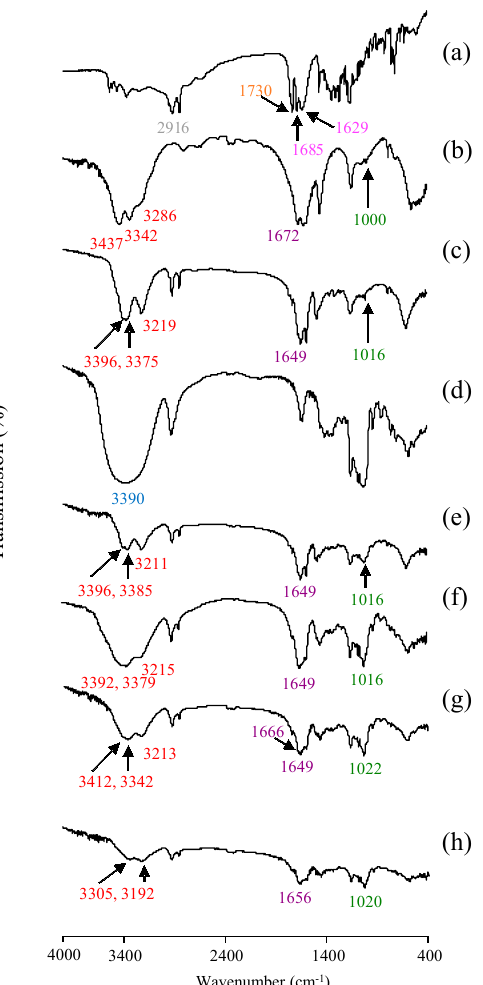
Figure 5. IR Spectra of AU (ASCP/UR = 1/12)/ γ CD systems. ( a ) ASCP intact, ( b ) UR intact, ( c ) EVP AU (ASCP/UR = 1/12), ( d ) γ CD intact, ( e ) PM (AU (ASC/UR = 1/12)/ γ CD = 1/1), ( f ) PM (AU (ASC/UR = 1/12)/ γ CD = 1/2), ( g ) GM (AU (ASC/UR = 1/12)/ γ CD = 1/1), ( h ) GM (AU (ASC/UR = 1/12)/ γ CD = 1/2).